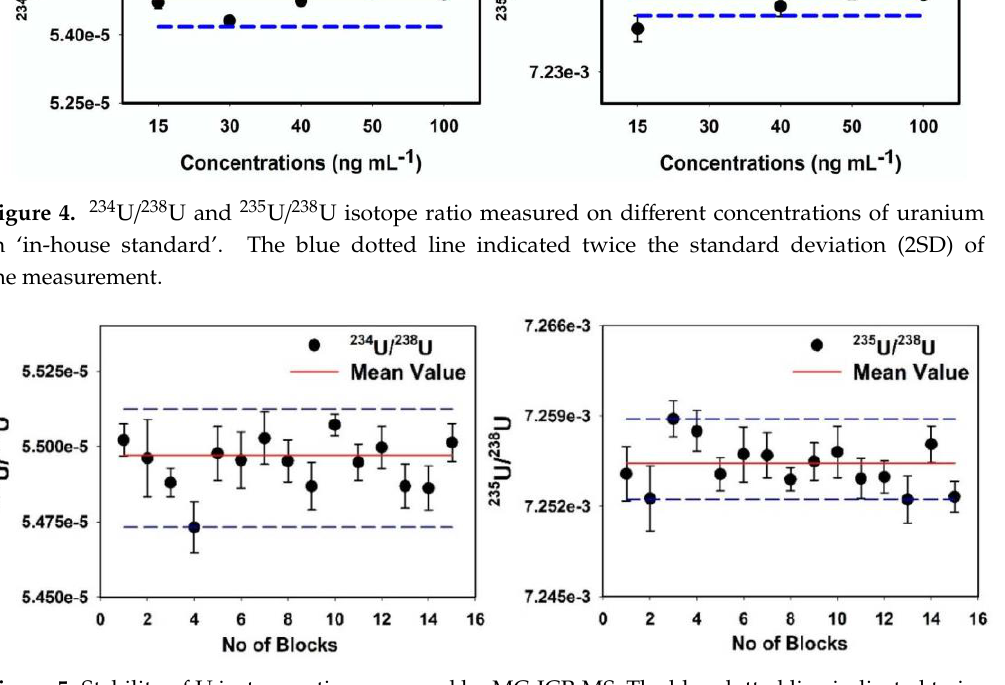
Figure 5. Stability of U isotope ratios measured by MC-ICP-MS. The blue dotted line indicated twice the standard error (2SE) of the measurement.